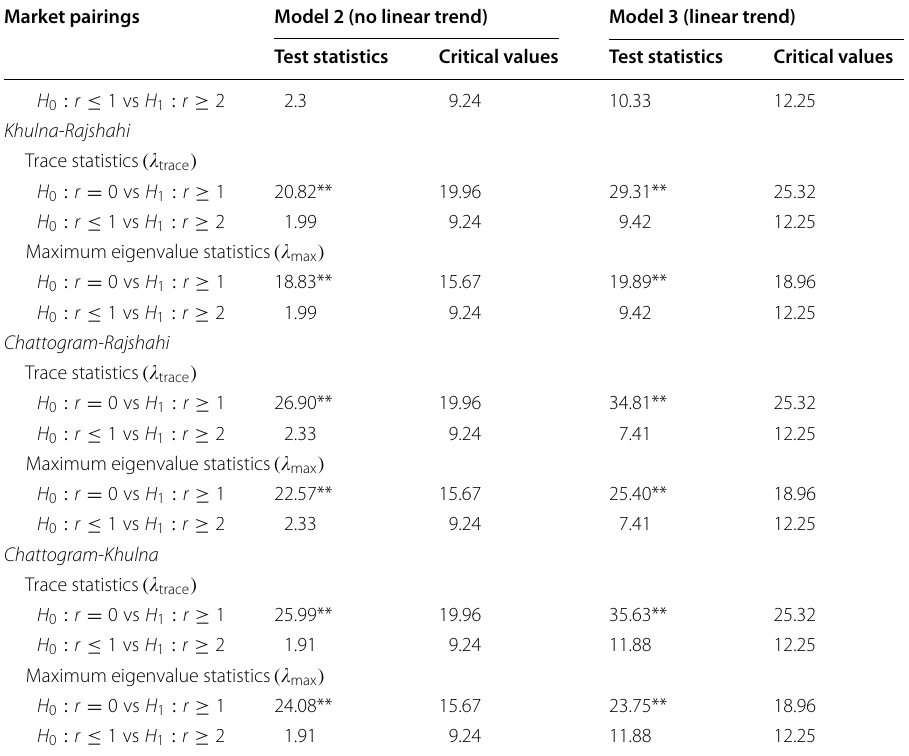
Table 4 Long-run elasticity and the speed of adjustment coefficients Market pairs (right hand is normalized as explanatory market)